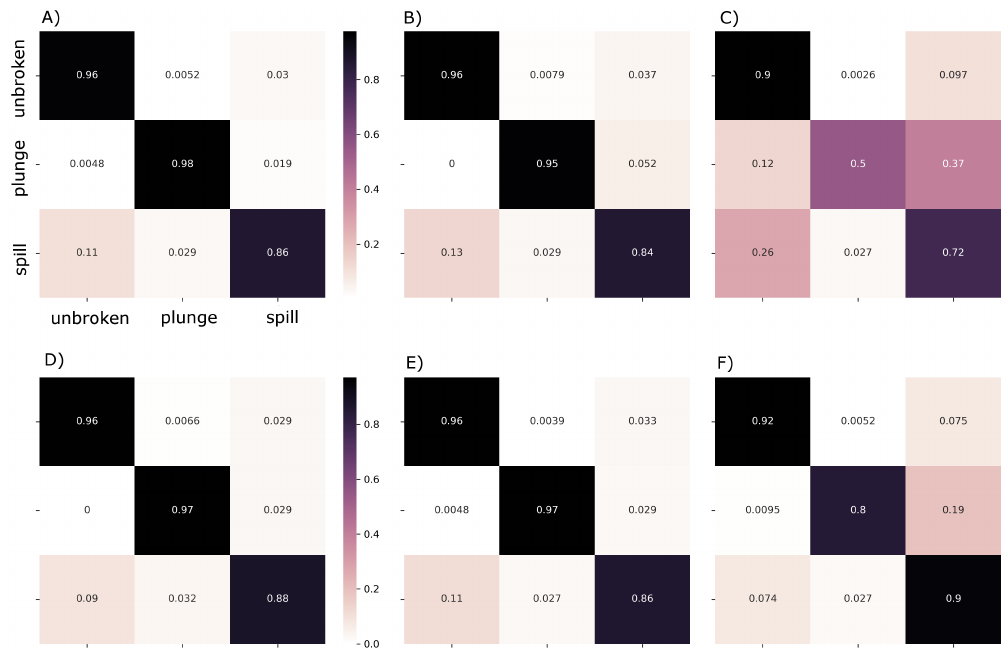
Figure 4. Confusion matrices for models training with image augmentation: ( A ) MobilenetV2; ( B ) Xception; ( C ) Resnet-50; ( D ) InceptionV3; ( E ) Inception-ResnetV2; ( F ) VGG19. For each confusion matrix, the abscissa represents estimated and the ordinate represents